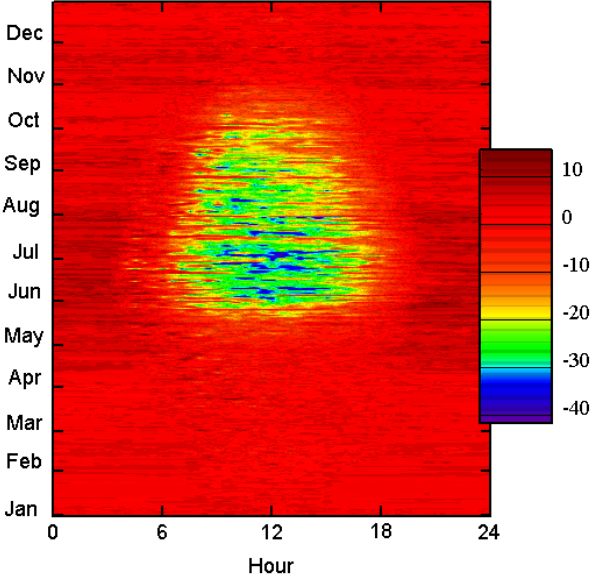
Fig. 4. A typical (2003) net ecosystem exchange (NEE) “finger- print” plot showing diurnal (x-axis) and seasonal (y-axis) CO 2 fluxes (µmolm − 2 s − 1 ) for the oak plantation at the Straits Inclo- sure, Alice Holt Forest, generated by the CarboEurope on-line gap filling and partitioning tool.